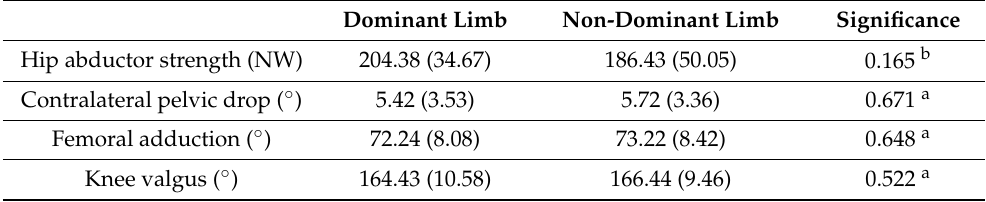
Table 2. Mean and standard deviations of hip strength and frontal plane kinematics.